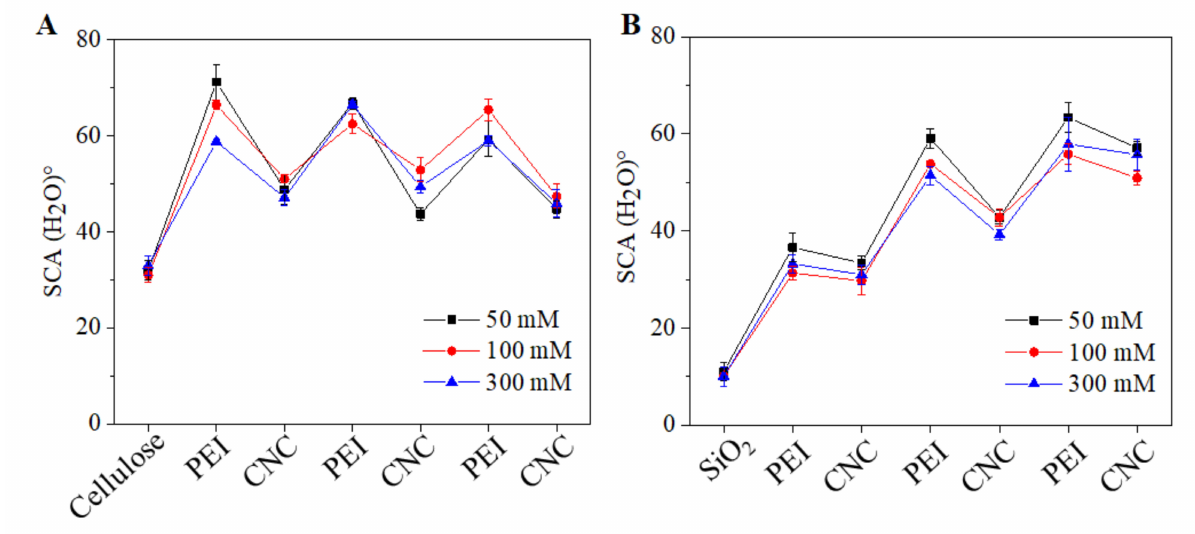
Figure 6. Static water contacts (SCA(H 2 O) ◦ ) of the sequentially adsorbed PEI (at 50–300 mM NaCl) and CNCs on cellulose ( A ) and SiO 2 ( B